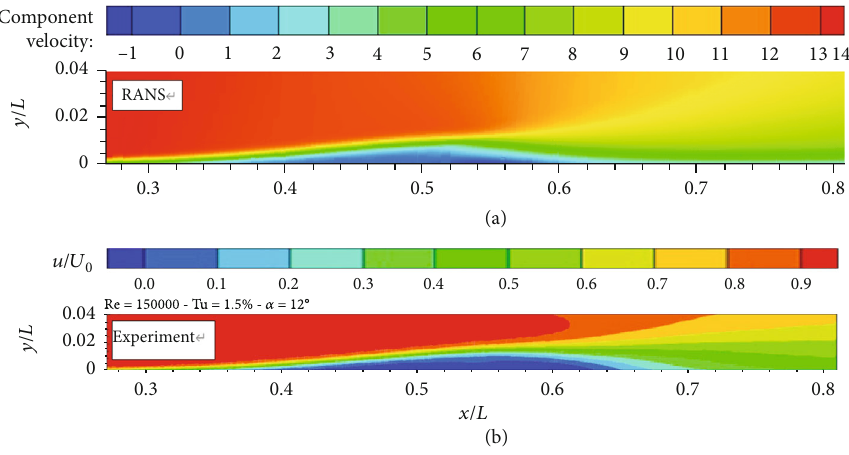
Figure 6: Color contour of velocity component u ((a) simulation and (b) experiment).